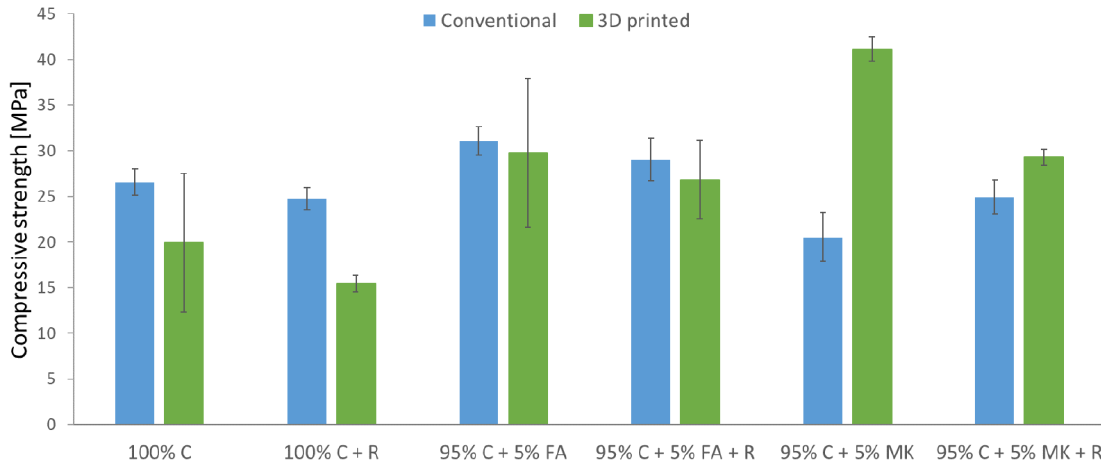
Figure 7. Compressive strength after the UV aging tests.